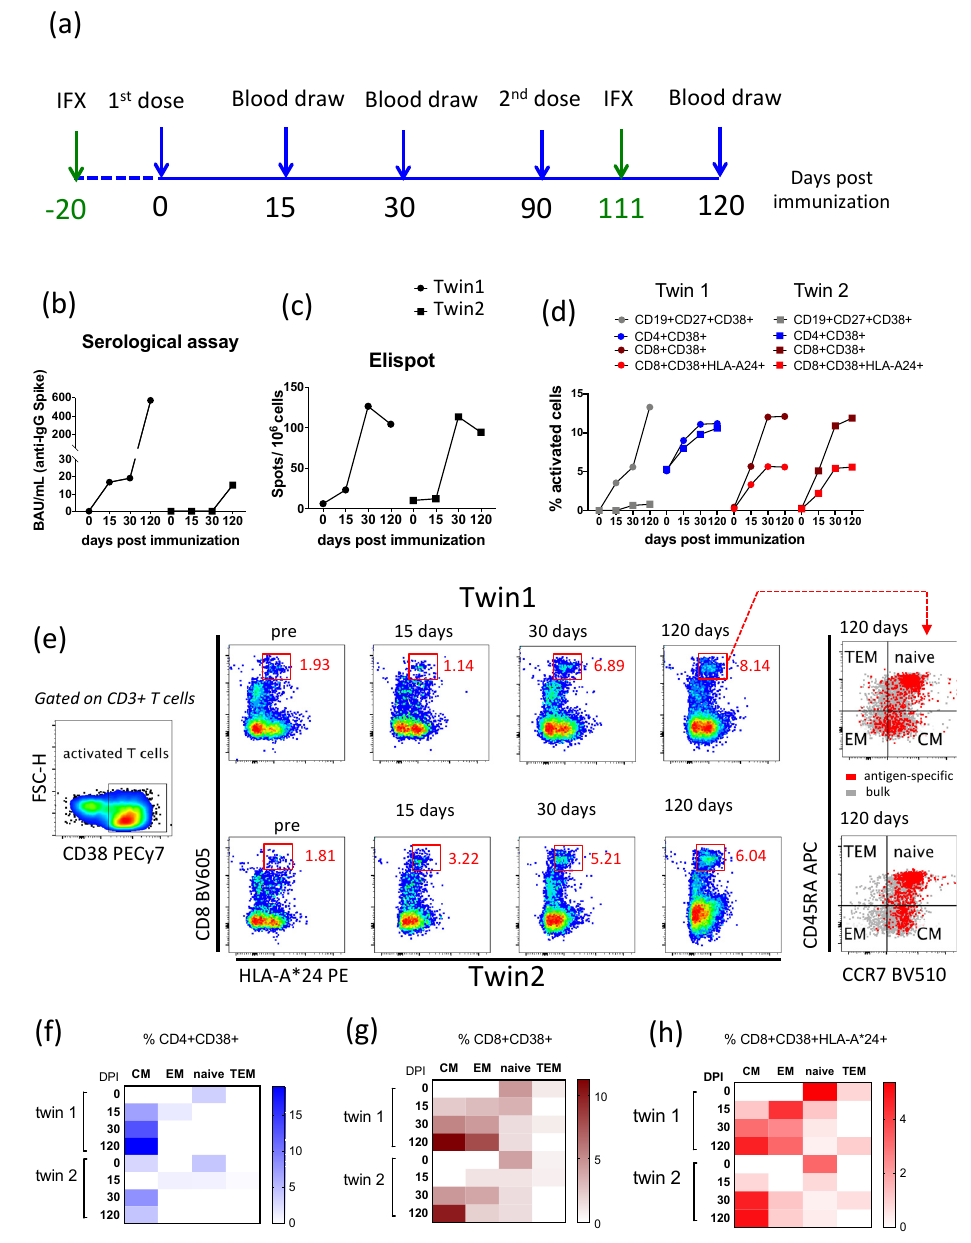
Figure 1. Immunological findings from the twins vaccinated against SARS-CoV-2. ( a ) The time line of the follow-up performed with monozygotic twins at days post immunization with the AstraZeneca COVID-19 vaccine, including the blood draw collection to perform immunological assays, and the days of intravenously biological treatment using infliximab (IFX) by twin 2 are highlighted in green. ( b ) Serological assay to detect specific anti-spike glycoprotein (SARS-CoV-2) antibody. ( c ) Elispot assay to detect IFN γ -secreted cells. ( d ) Percentage of polyclonal activation (CD38+) for B and T lymphocytes subsets after spike glycoprotein peptides stimulation. ( e ) Gates representing the percentage of activated CD8+ T cells expressing HLA-A*24 after antigenic stimulation over time (red chart gates), as well as those cells gated on memory subsets for both twins. Memory T cells subsets were based on CCR7 and CD45RA co-expression—TEM: terminally differentiated memory cells (CCR7-CD45RA+); CM: central memory cells (CCR7+CD45RA-); EM: effector memory cells (CCR7-CD45RA-); Naïve (CCR7+CD45RA+). ( f ) Percentage of activated CD4+ T cells after cell stimulation with spike glycoprotein. ( g ) Percentage of activated CD8+ T cells after cell stimulation with spike glycoprotein. ( h ) Percentage of activated CD8+HLA-A*24+ T cells after cell stimulation with spike glycoprotein. Baseline signals of activated cells in unstimulated controls were subtracted from SARS-CoV-2-stimulated assays to enable the visualization of SARS-CoV-2- specific B and T cells signals. Abbreviations—DPI: days post immunization. IFX: infliximab